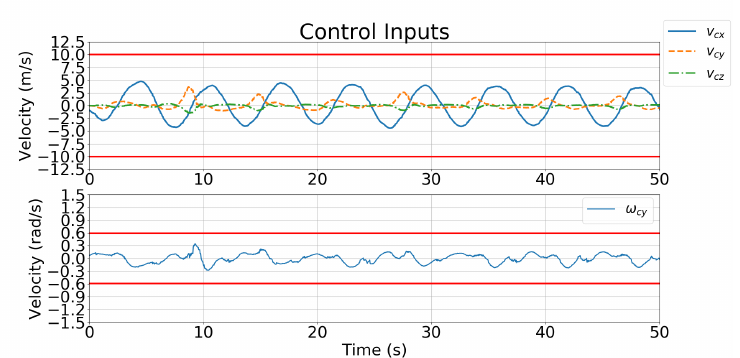
Figure 11. Simulation 1: velocity control input for Case